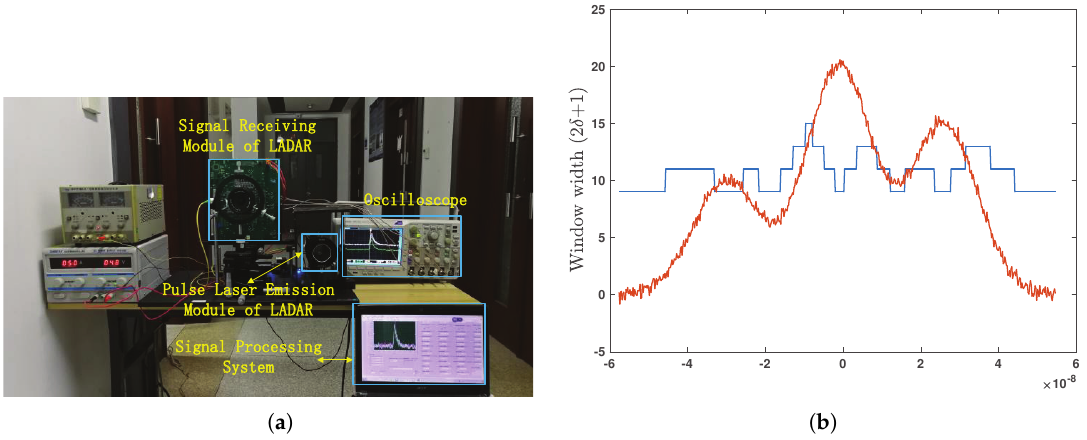
Figure 3. ( a ) LADAR system; ( b ) window width (2 δ +1) changing with